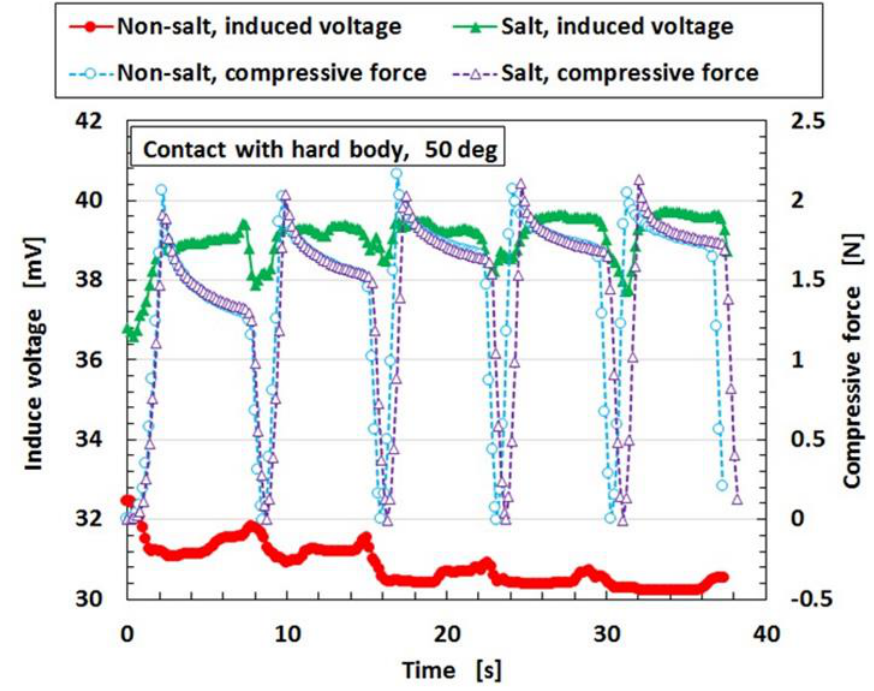
Figure 20. Induced voltage in salt water with compression.